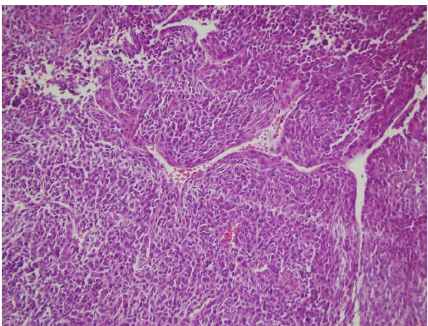
Figure 1: Richly vascularized structure of the tumor with staghorn- appearing vessels (H&E × 20).